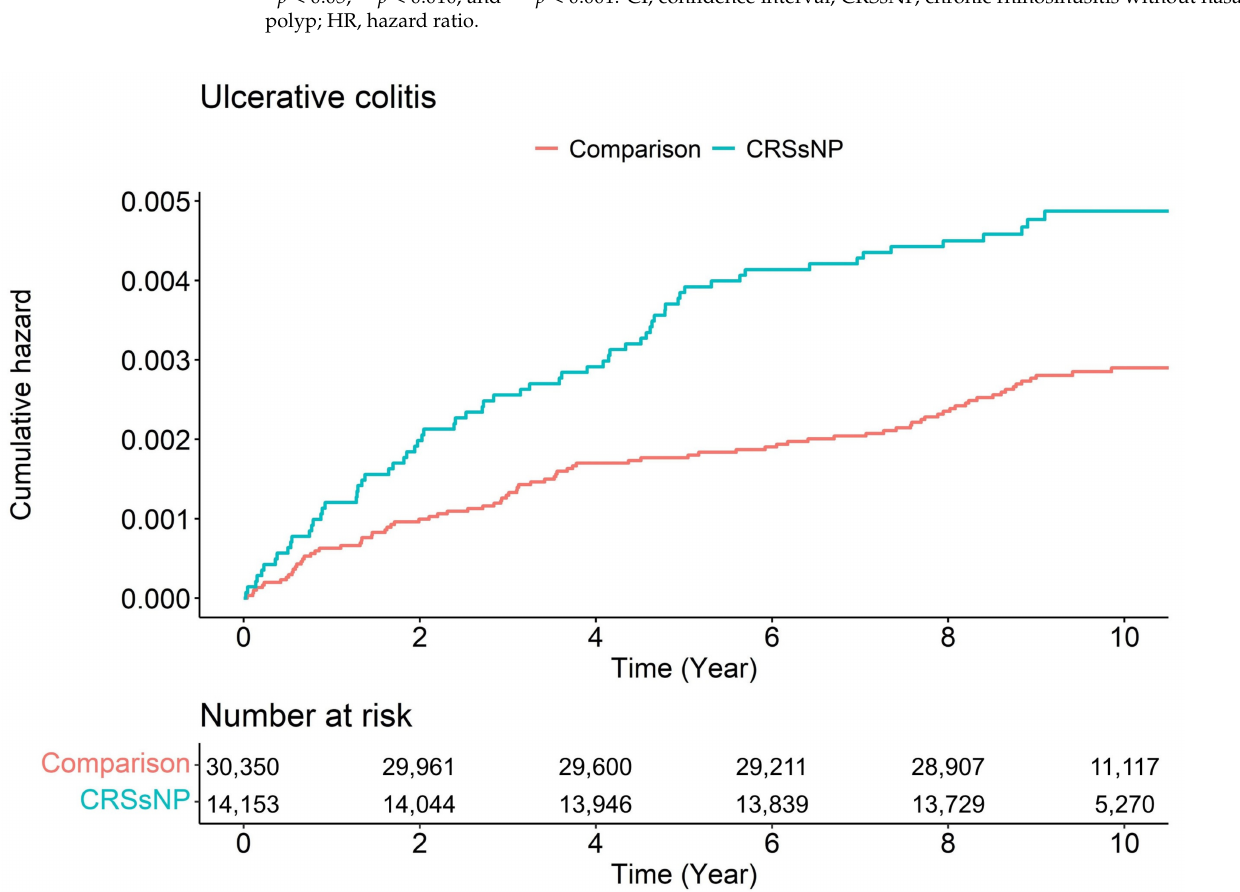
Figure 3. Hazard ratios for incident ulcerative colitis associated with the development of chronic rhi- nosinusitis with nasal polyp by time since the diagnosis of chronic rhinosinusitis without nasal